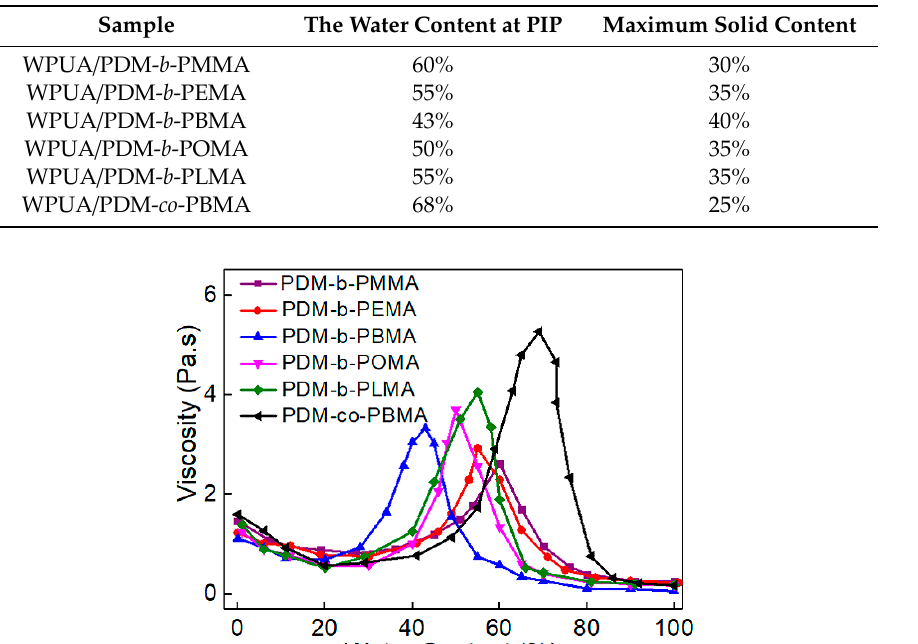
Table 4. The maximum solid content of WPUA/PDM -b -PRMA and WPUA/PDM- co -PBMA emulsions.